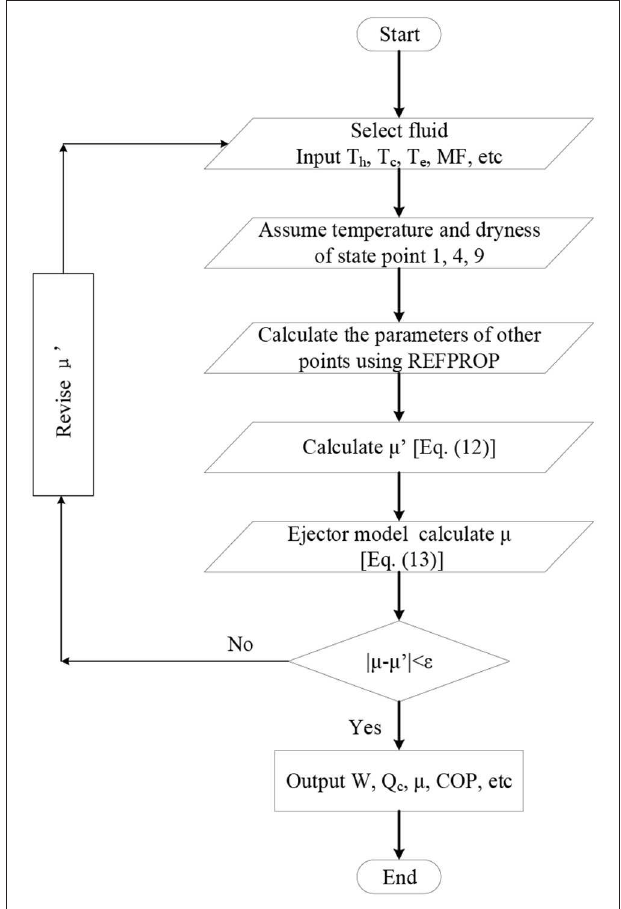
FIGURE 2 | Simulation flowchart of the combined system performance